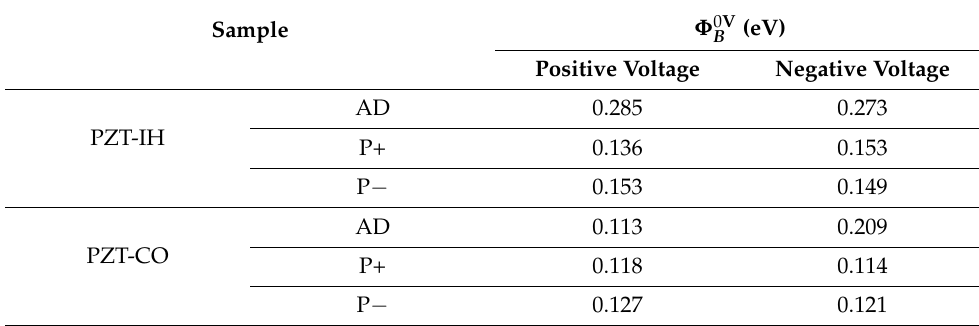
Table 2. The potential barrier at zero volt Φ B 0 extracted from the I–V characteristic recorded at different temperatures following the procedure from